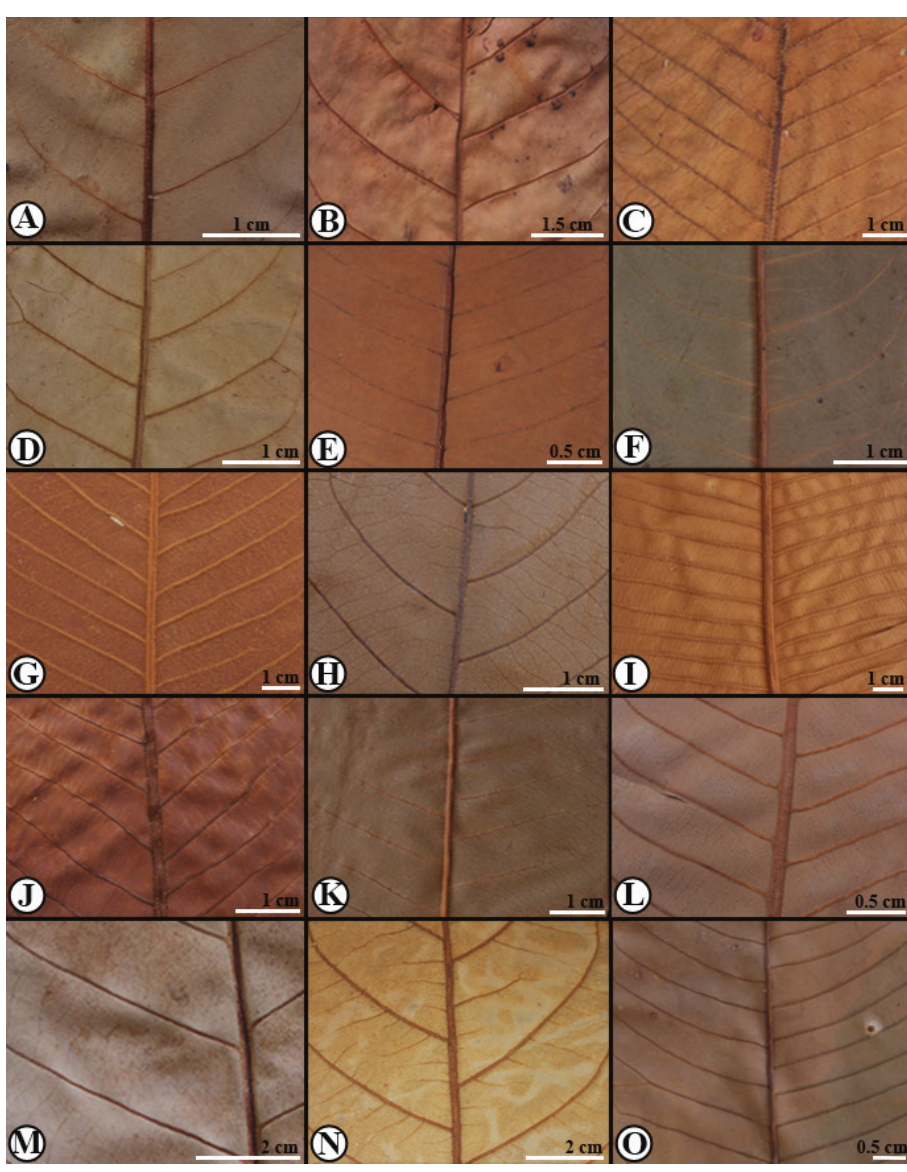
Figure 8. Pattern of the lateral veins in Mesoamerican Virola A Virola allenii ( K. Thomsen 1284, NO) B V. amistadensis ( G. McPherson 8703 , MO) C V. chrysocarpa ( B. Hammel et al.16864 , MO) D V. elongata ( M. Correa & R. L. Dressler 1078 , MO) E V. fosteri ( G. de Nevers 7226 , MO) F V. guatemalensis ( G. Ibarra 957 , MO) G V. koschnyi ( J. Miller & J. C. Sandino 1110 , MO) H V. laevigata ( N. Zamora & T. D. Pen- nington 1583, MO) I V. megacarpa ( G. de Nevers 5184 , MO) J V. montana ( E. Lépiz & J. F. Morales 284 , MO) K V. multiflora ( J. Manzanares 3561 , MO) L V. nobilis from Barro Colorado ( R. J. Schmalzel 320 , MO) M V. otobifolia ( G. de Nevers et al. 7530 , MO) N V. sebifera ( T. B. Croat 5959 , MO) O V. nobilis from Osa Peninsula ( R. Aguilar 11186 ,